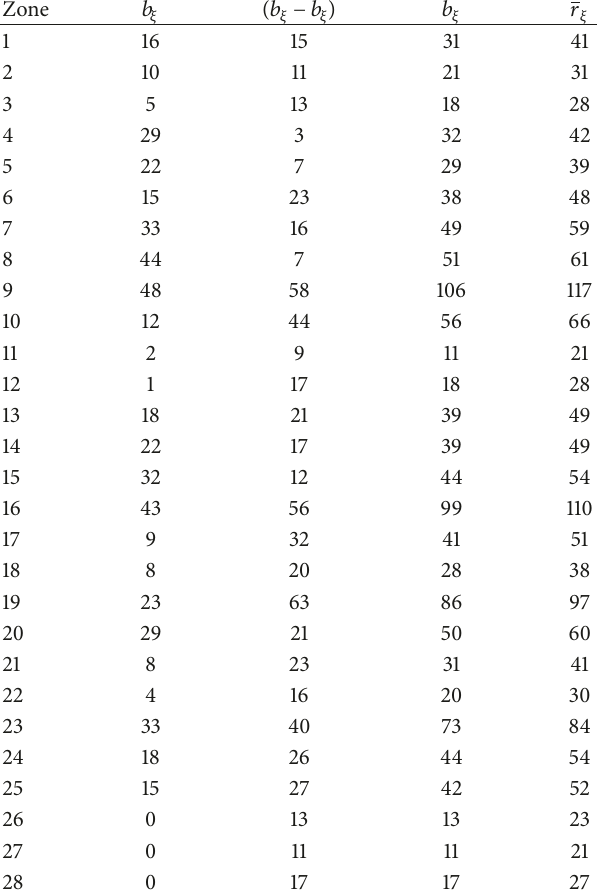
Table 7: Results for Molfetta, 𝑀 < 𝑅